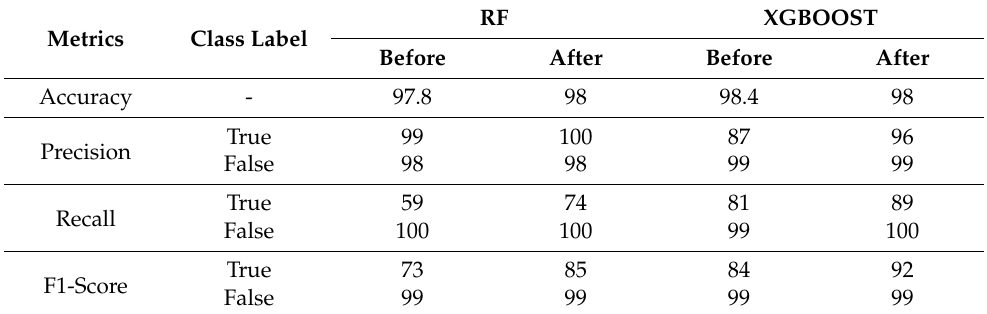
Table 3. Effect of fine-tuning hyperparameters on performance metrics of Random Forest (RF) and Extreme Gradient Boosting (XGBOOST)-based algorithms.